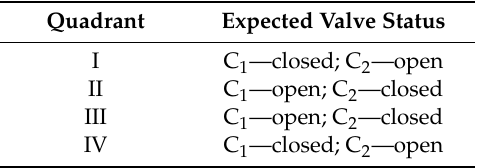
Table 2. Expected behaviour of valves C 1 and C 2 at each operational quadrant.